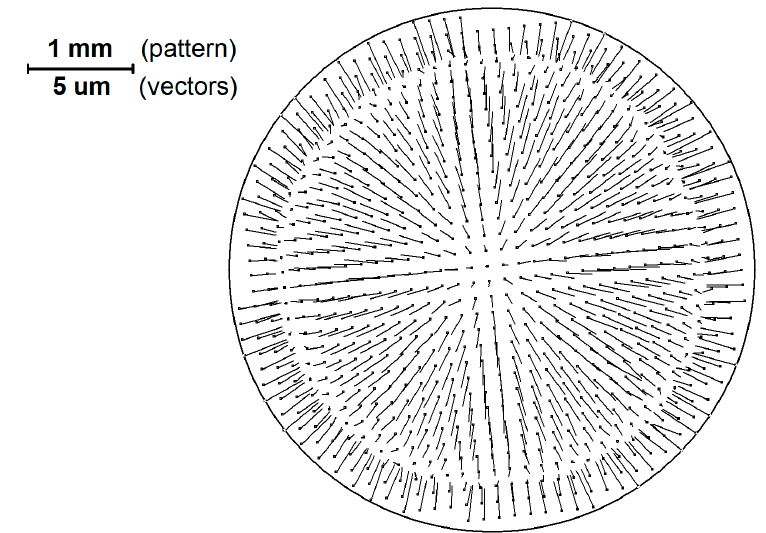
Figure 3. The structure of vectors that display the displacement of the elements of the pattern image relative to the ideal grid (enlarged 200 times compared to the scale of the pattern).